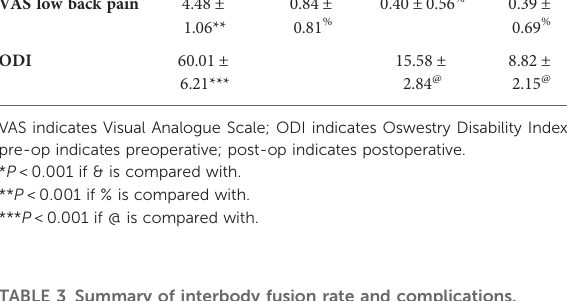
TABLE 3 Summary of interbody fusion rate and complications.